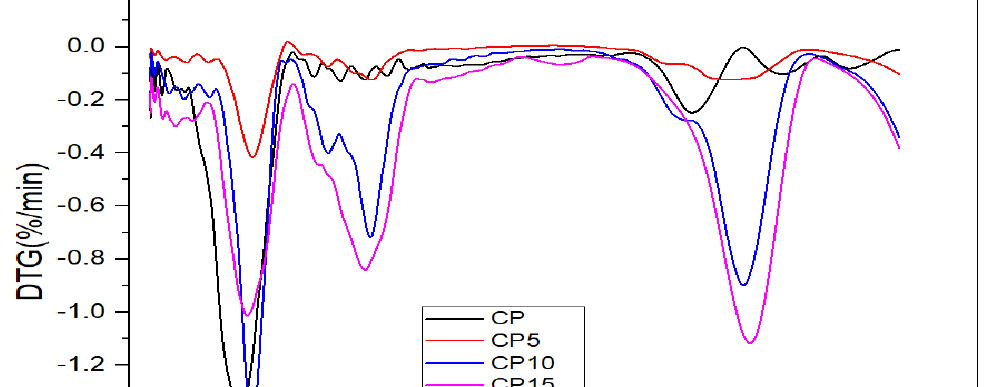
Figure 2. TGA of all samples.